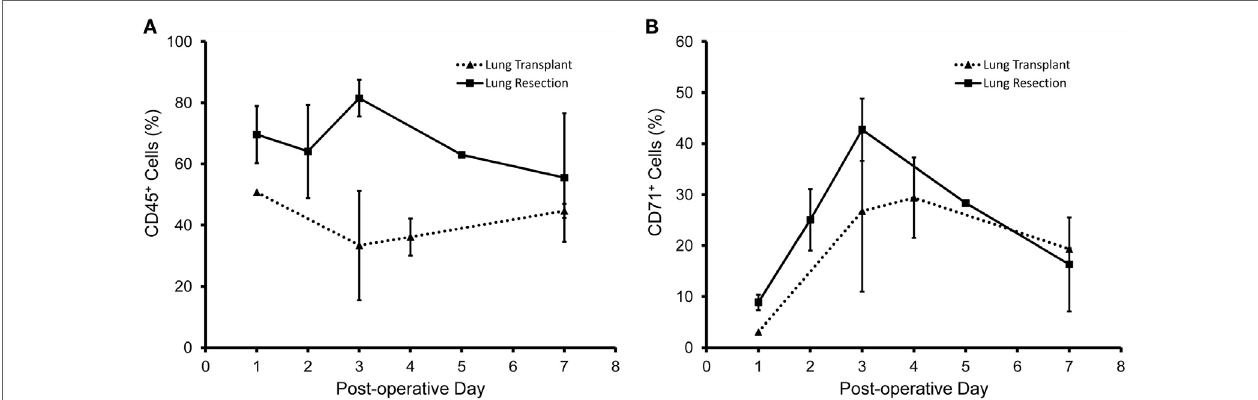
FigUre 5 | Time course of pleural fluid cell populations after surgery. Pleural fluid obtained from patients after lung resection (solid line) and lung transplant (dotted line) are shown. (a) Leukocytes, identified by anti-CD45 antibodies, were a relatively consistent percentage of cells during the first week after surgery. (B) In contrast, the percentage of CD71 + cells peaked 3 days after surgery. Data based on N = 40 patients. Error bars reflect ± 1 SD.